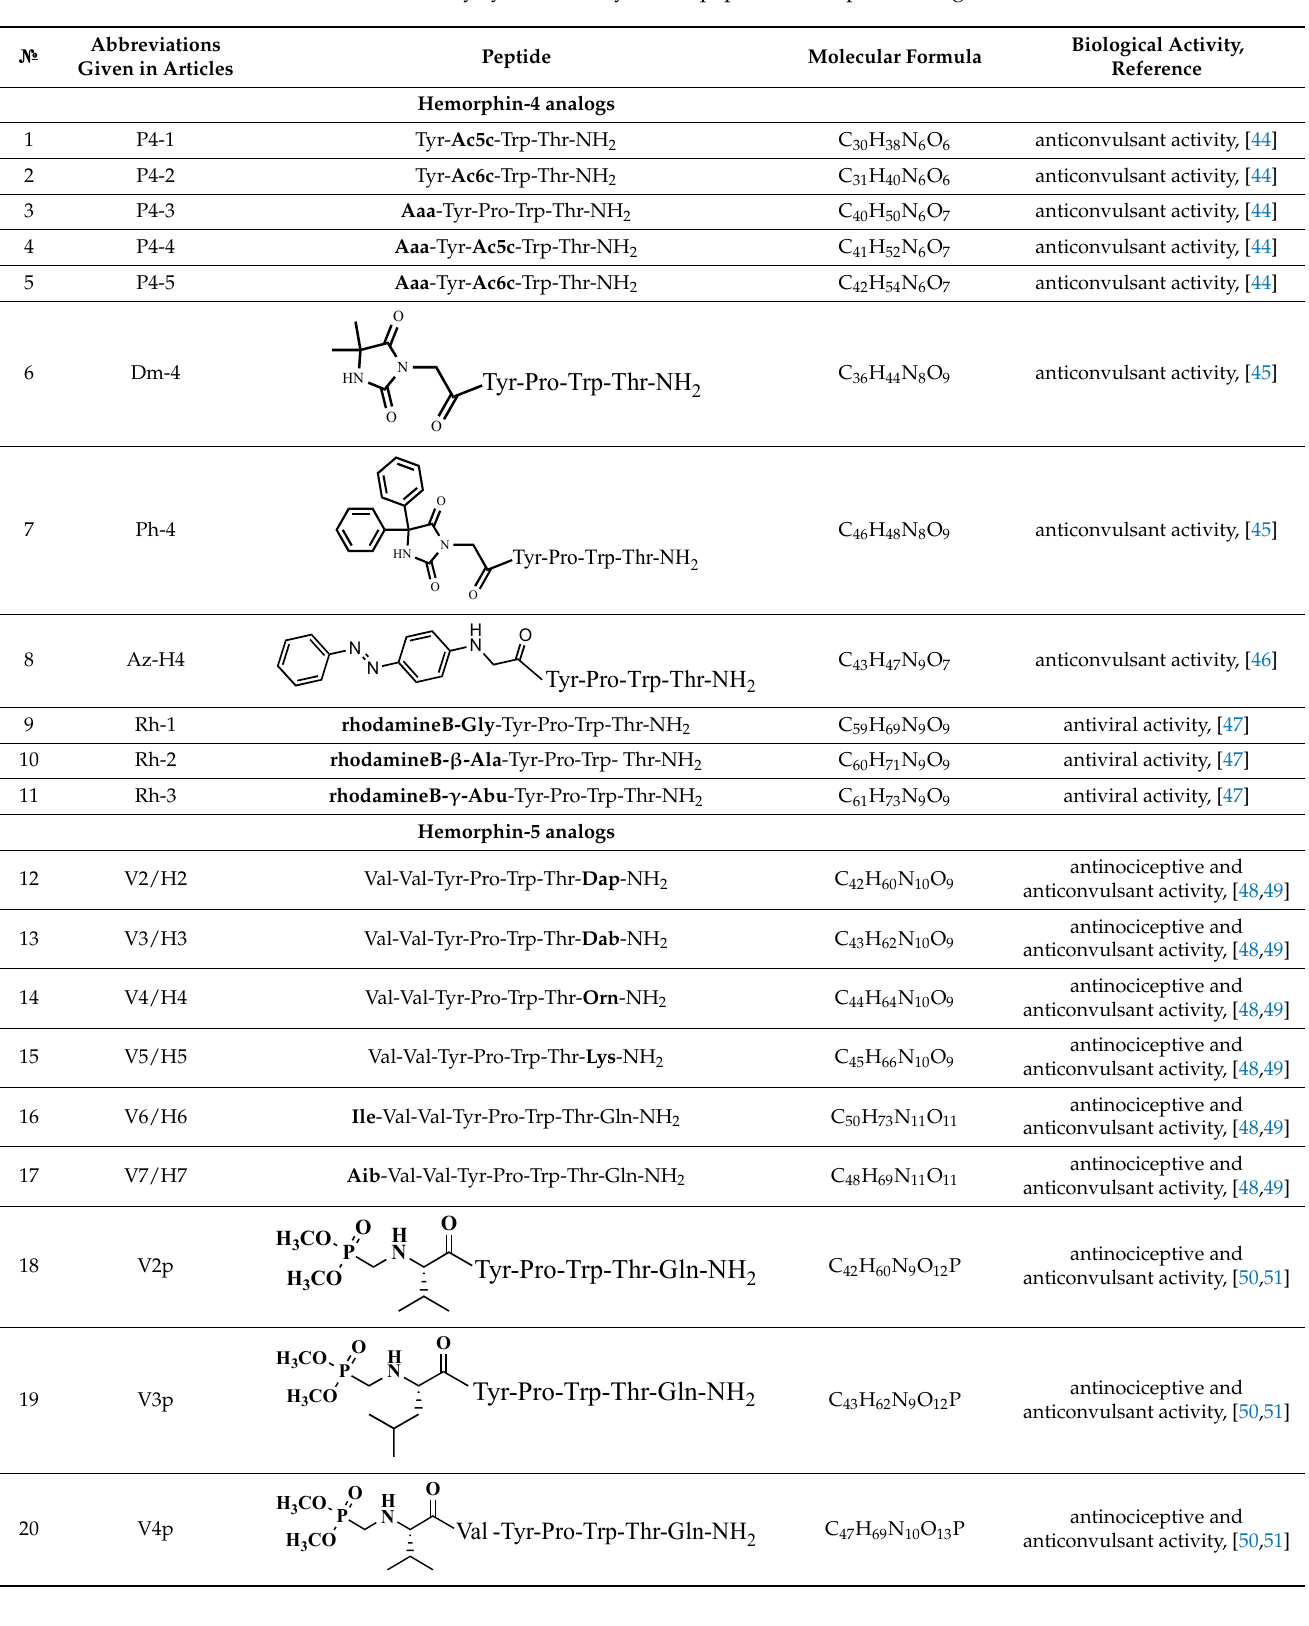
Table 1. Newly synthesized synthetic peptide hemorphin analogs.